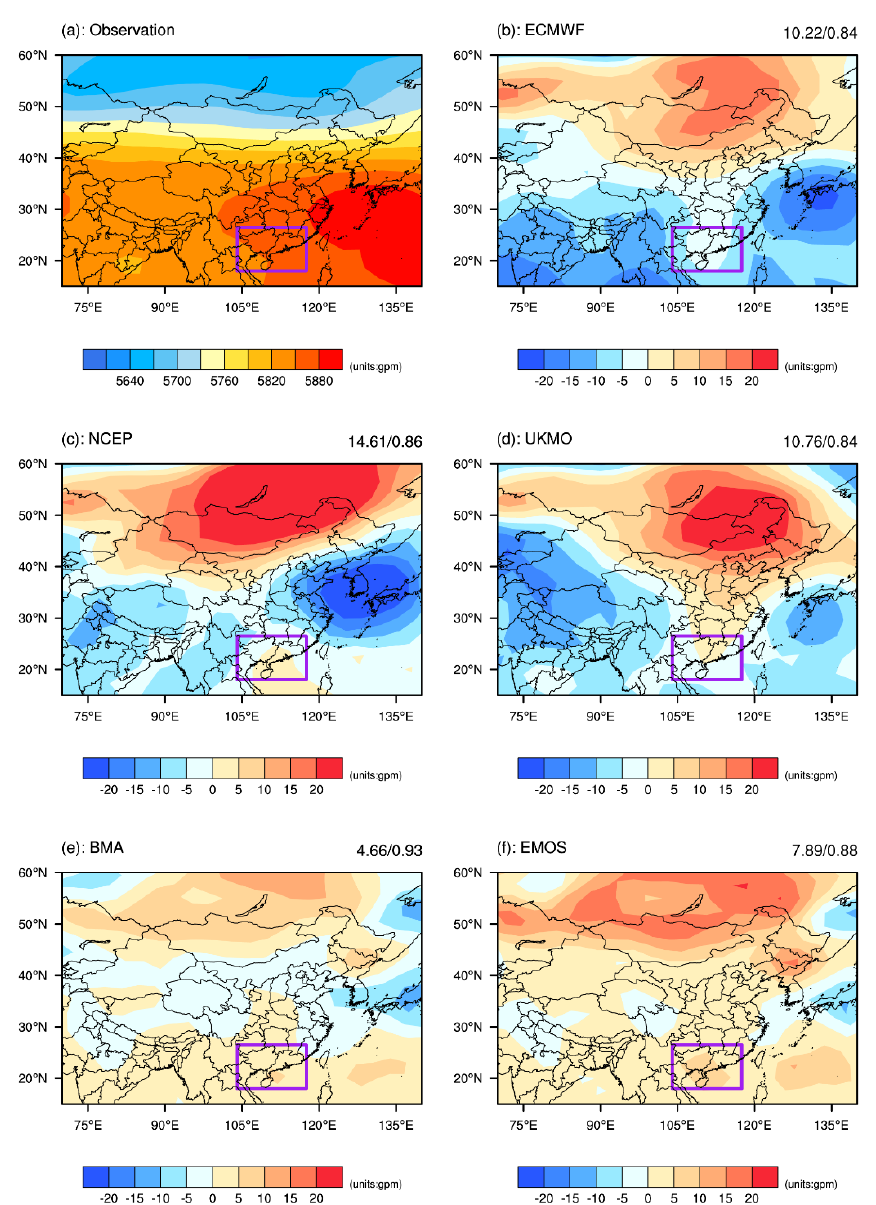
Figure 2. Mean 500 hPa geopotential height distribution from 1 July to 20 August 2013 for ( a ) the observations, the difference between the observations and the ensemble mean of the ( b ) ECMWF, ( c ) NCEP and ( d ) UKMO EPSs with a lead time of 7 days and the difference between the observations and the deterministic forecast of the ( e ) BMA and ( f ) EMOS with a lead time of 7 days. The root mean square error and anomaly correlation coefficient between the forecasts and the observations are shown in the upper right-hand corner of each part. The purple box denotes the South China region.